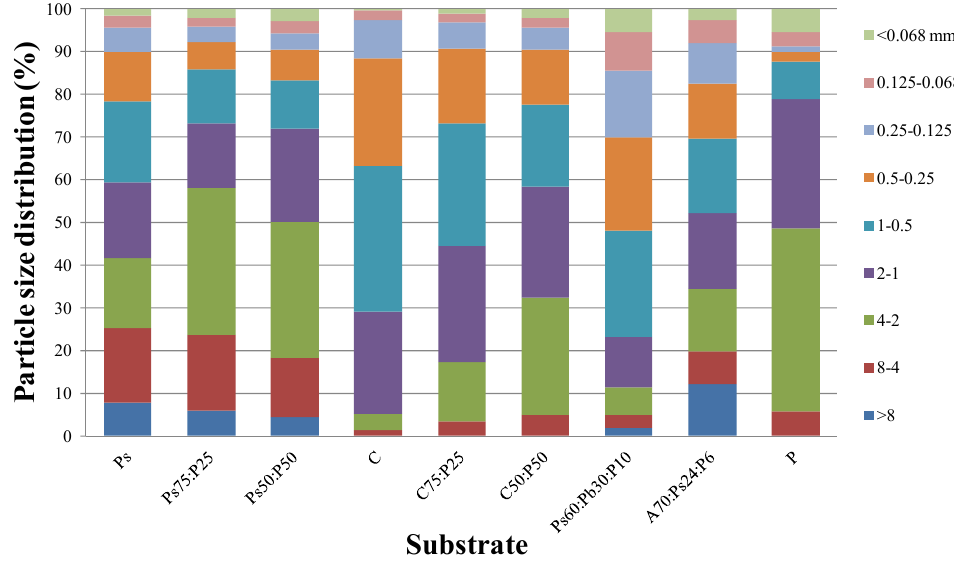
Figure 3. Particle size distribution of the substrates. Values are the means of three replications ( n = 3).